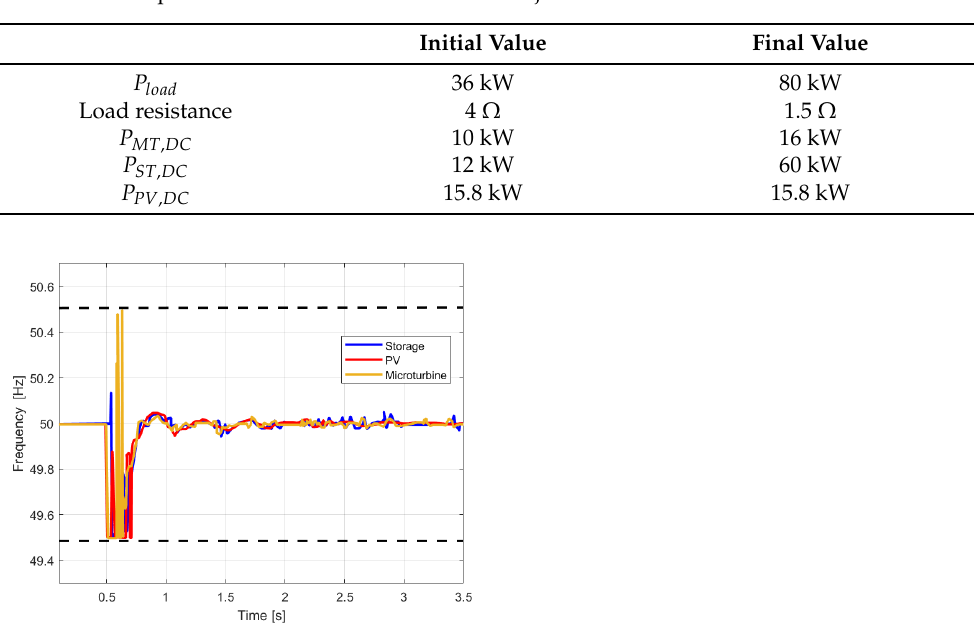
Table 10. Power production variation to achieve the objective.